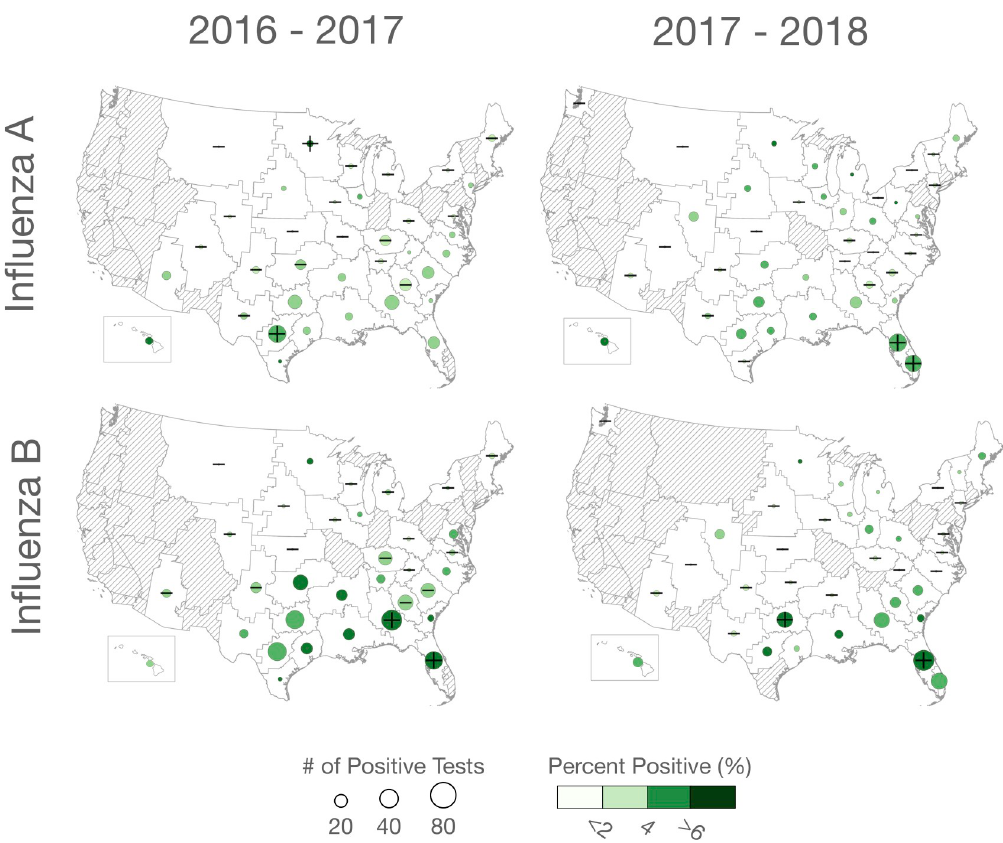
Fig 3. Percent-positivity rates during the baseline season for influenza A and B during 2016–2017 and 2017–2018. Plus/minus symbols indicate subregions where the ratio was significantly below/above expected value (based on Fisher’s exact tests). Dashed areas are subregions with no or inadequate numbers of positive